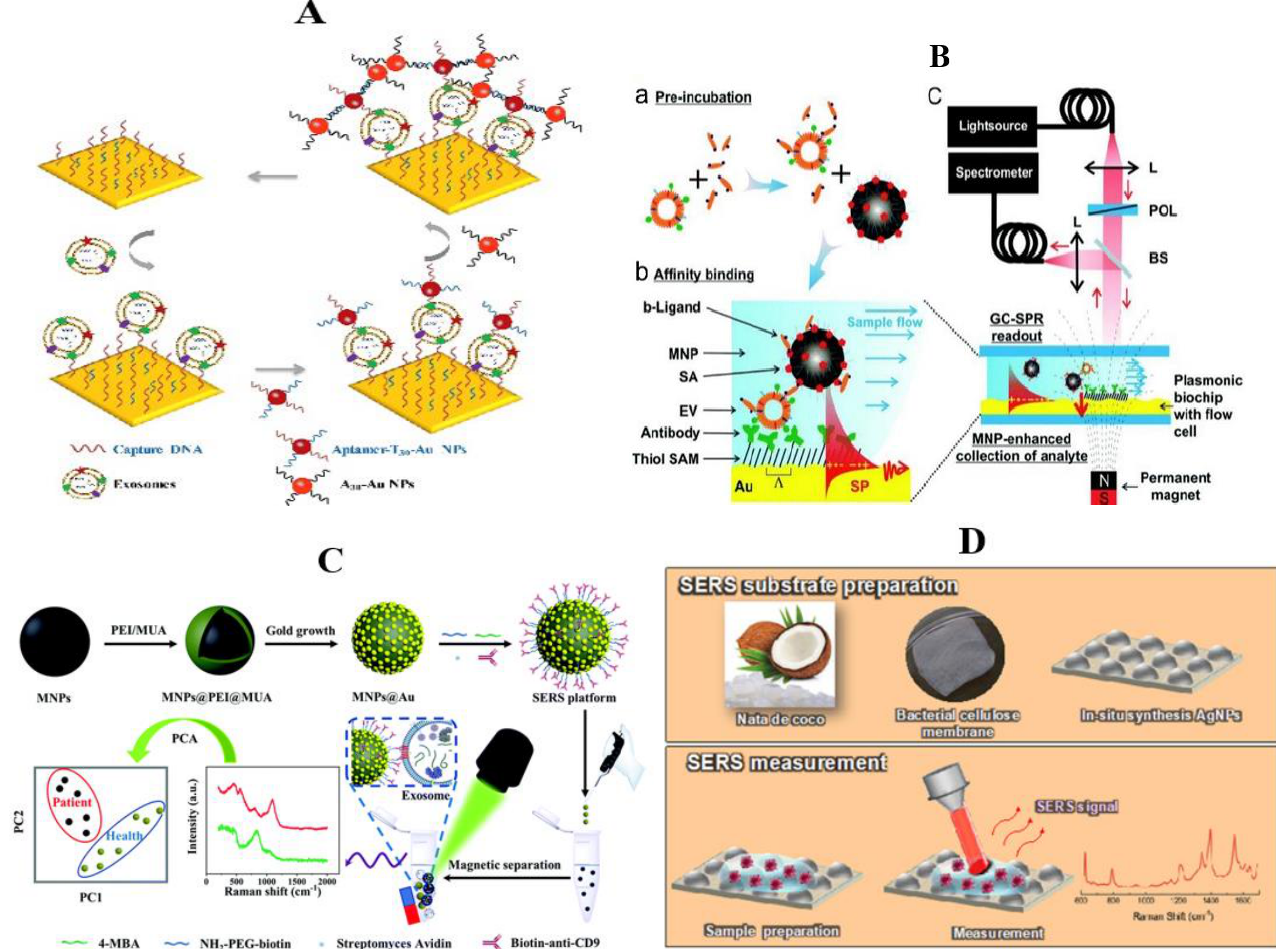
Figure 6. Surface plasmon resonance and surface-enhanced Raman scattering detection of exosomes in breast cancer. ( A ) Dual Au NPs-assisted signal amplification for determination of exosomes [112]; ( B ) schematic of the grating-coupled SPR sensor system and developed assay. SAM, thiol self- assembled monolayer; SP, surface plasmon; L, lens; POL, polarizer; BS, beam splitter; GC-SPR, grating-coupled surface plasmon resonance [113]. ( C ) Schematic diagram of the construction of the magnetic SERS platform and its application for isolation and analysis of breast cancer exosomes [119]; ( D ) schematic representation of the system used in this work. The top panel shows BC membrane production from commercial nata de coco cubes and in situ synthesis of AgNPs into BC for SERS substrates production. The bottom panel shows SERS assay preparation, measurement, and the resulting spectrum